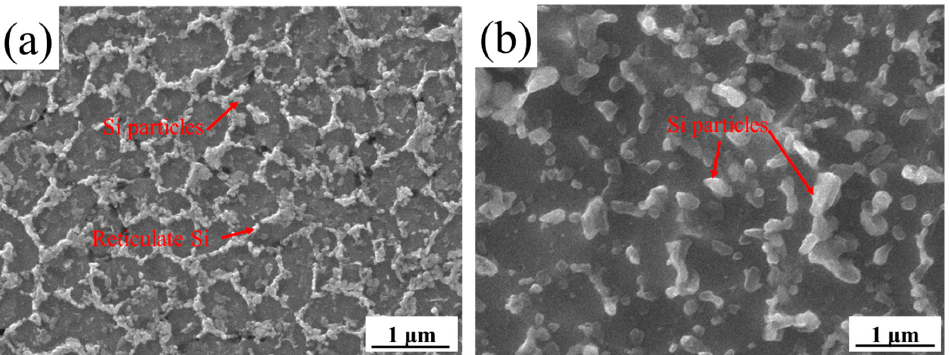
Figure 16. The microstructure photo of A3 sample after deep etching, ( a ) as ‐ printed status, ( b ) an ‐ nealing status at 275 °C/2 h. nealing status at 275 ◦ C/2